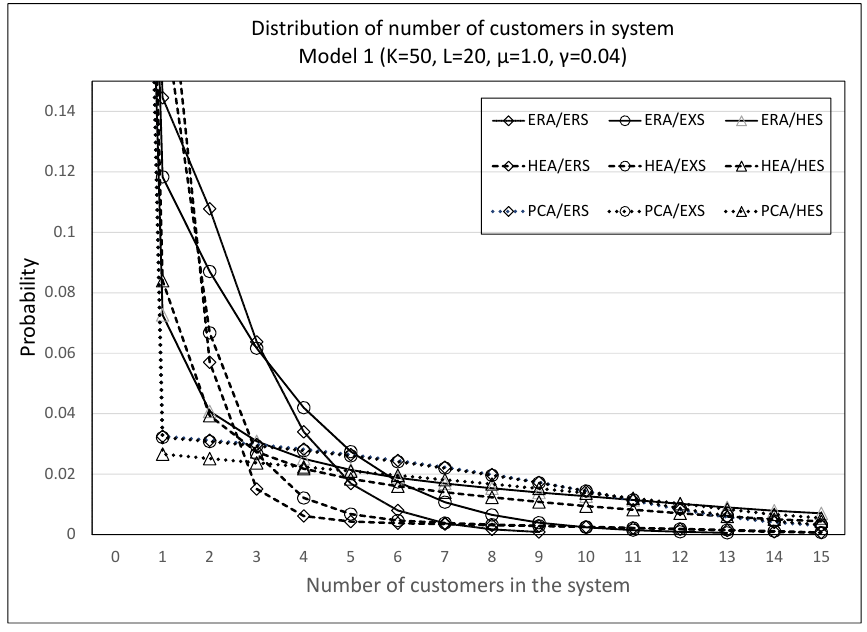
Figure 4. Marginal distributions of number of customers in the system (Model 1).